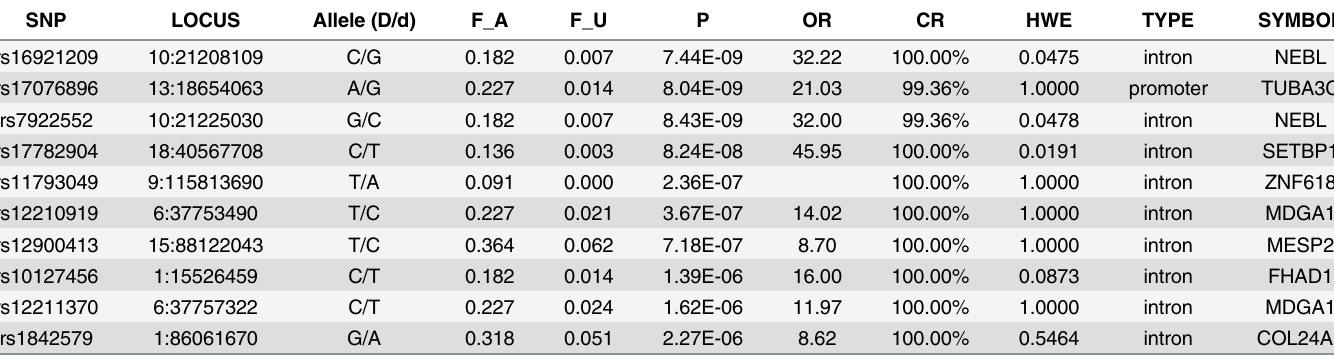
Table 2. Top 15 non-intergenic SNPs associated with susceptibility of CAA formation in KD. SNP LOCUS